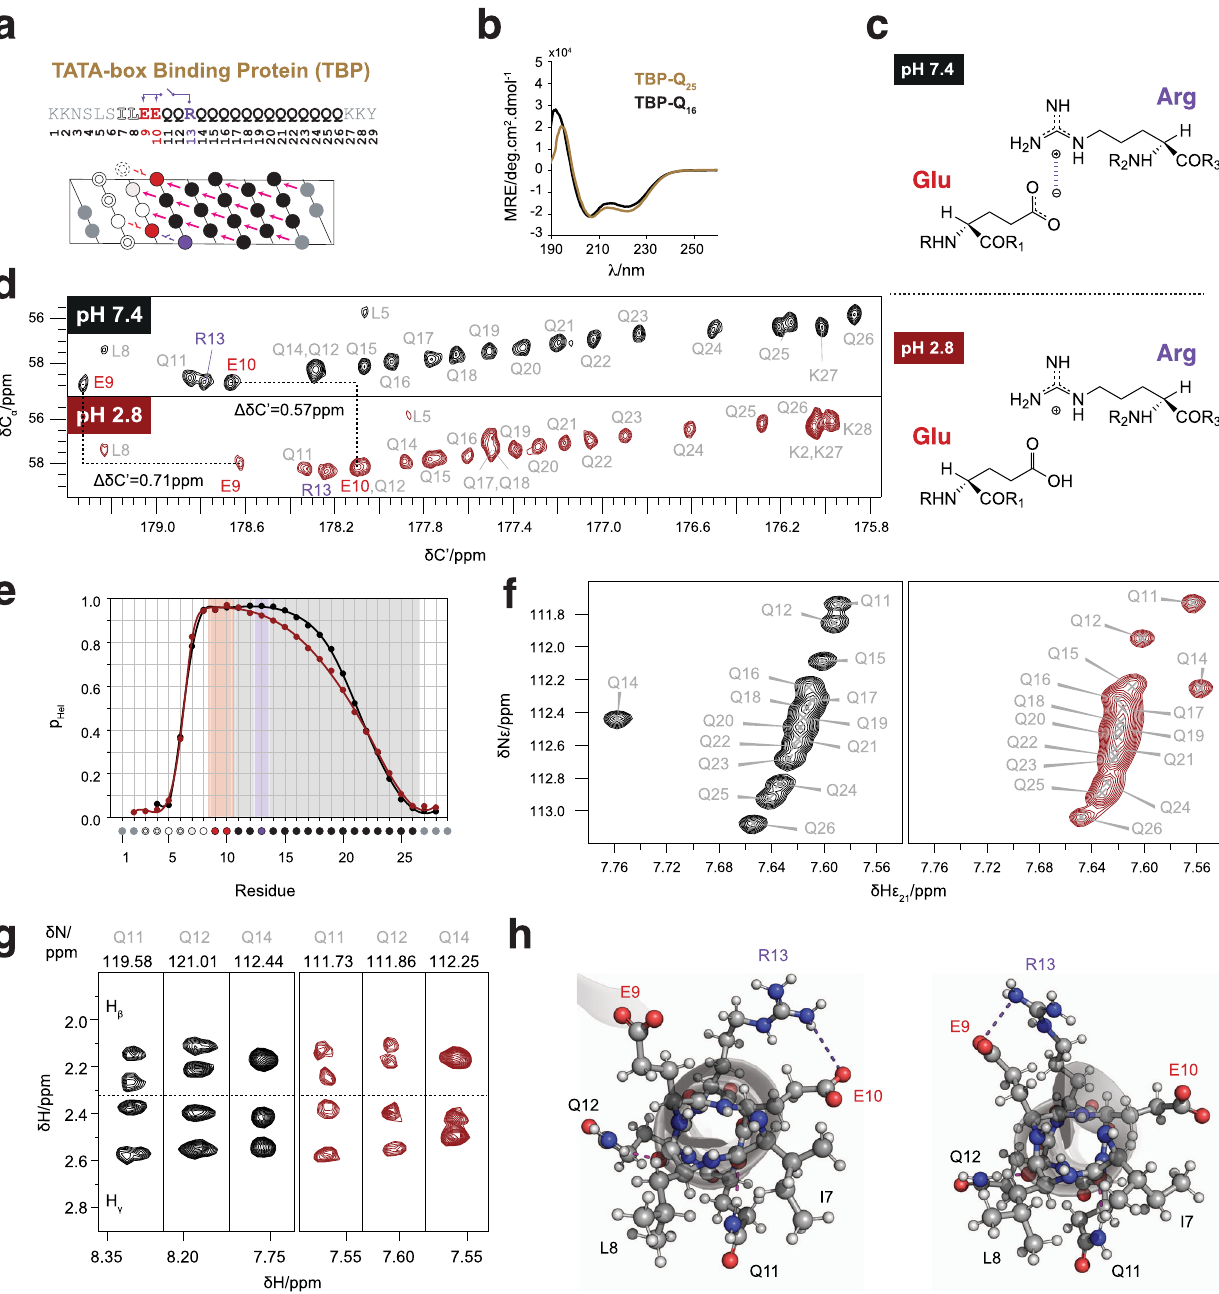
spectra of TBP at pH 7.4 (left, black) and 2.8 (right, dark red) displaying the side chain aliphatic 1 H resonances of the fi rst three Q residues in the polyQ tract. Strips were chosen from either N H or N ε 2 for clarity. h Frames from the MD trajectory obtainedforTBP.Anorthogonalviewofthehelixisshown.Intheleftpanel,aframe is shown where Arg13 ( i ) establishes an electrostatic interaction with E10 ( i-3 ), represented by the purple dashed line. Simultaneously, both Gln11 and Gln12 establish bifurcated hydrogen bondswith Ile7 and Leu8,respectively (pink dashed lines). Right: a frame where Arg13 ( i ) establishes an electrostatic interaction with Glu9 ( i-4 ), while the two bifurcated hydrogen bonds previously described are also